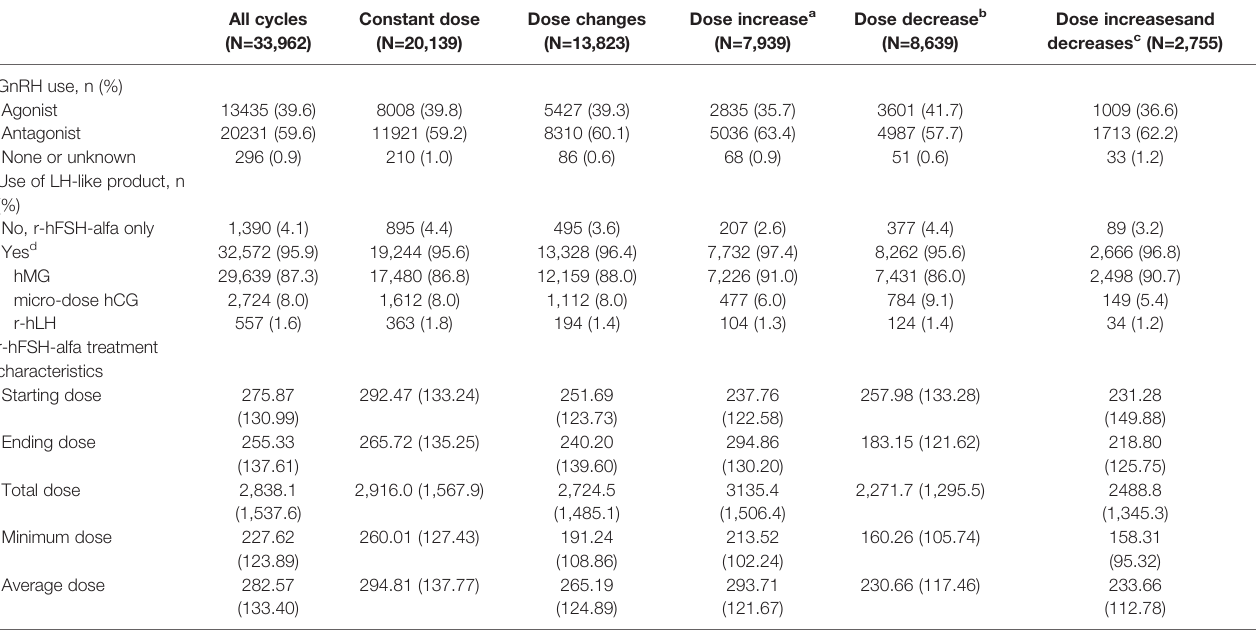
All cycles (N=33,962)